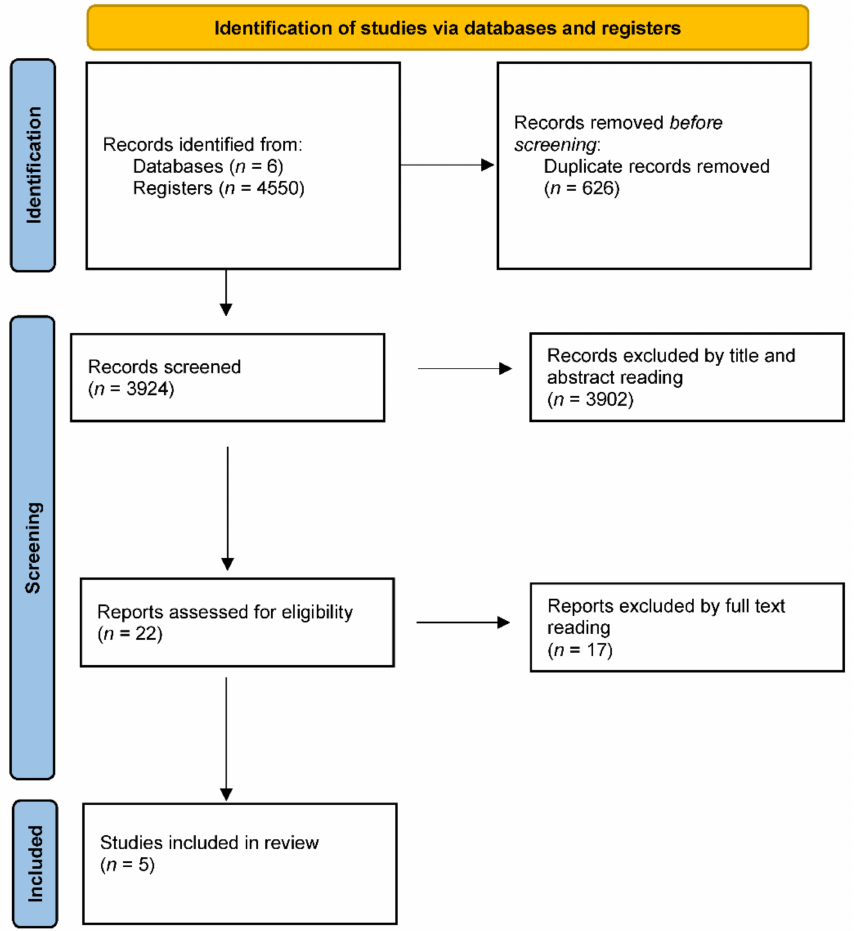
Figure 1. Article identification PRISMA flow